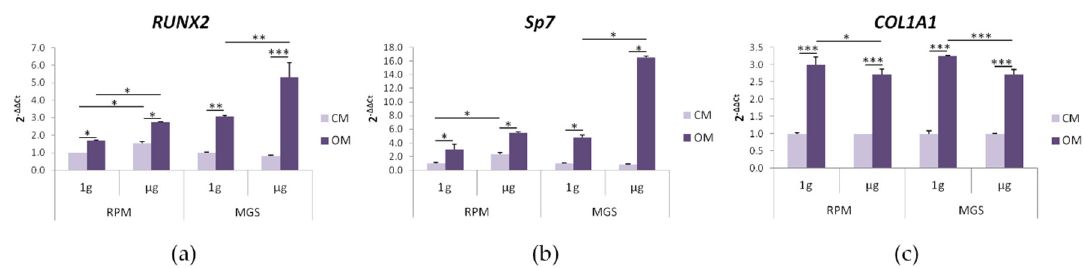
Figure 3. bMSC were cultured in the RPM or in the MGS as well as in 1 g-ground control for 4 days. Three different experiments were performed. RT-PCR was performed three times in triplicate on RNA extracted using primers designed on RUNX2 ( a ), Sp7 ( b ), and COL1A1 ( c ) sequences. * p < 0.05; ** p < 0.01; *** p < 0.001.